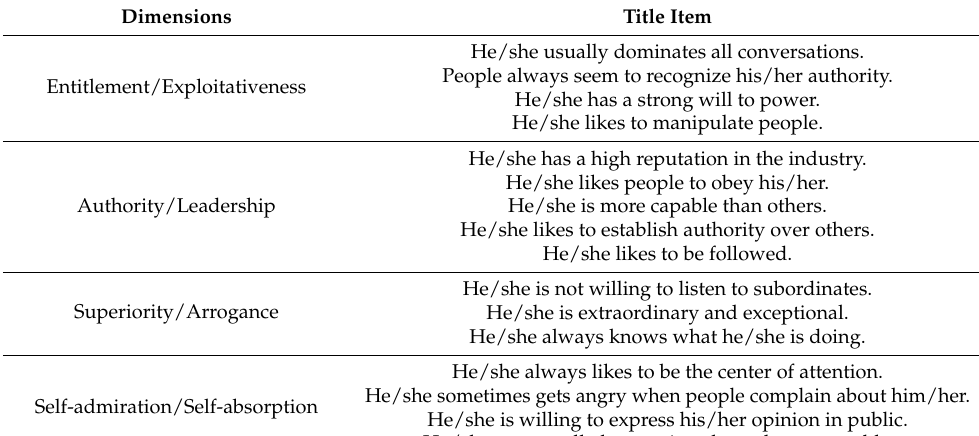
Table 1. Sixteen-item narcissistic personality index of